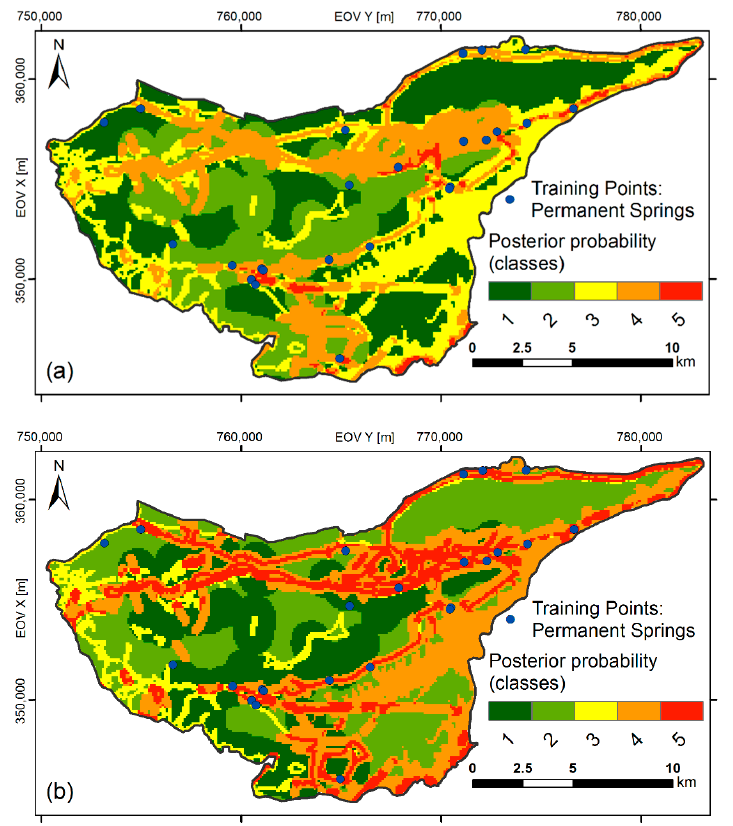
Figure 7. Contrasts (unitless) and adjusted contrasts (unitless) of the statistically significant classes of each evidential theme used to generate the maps in Figure 8 ( a ) DE: elevation, ( b ) FA: distance to faults, ( c ) CC: distance to the carbonate–non-carbonate rock contact and ( d ) SH: distance to sinkholes and sinking streams.